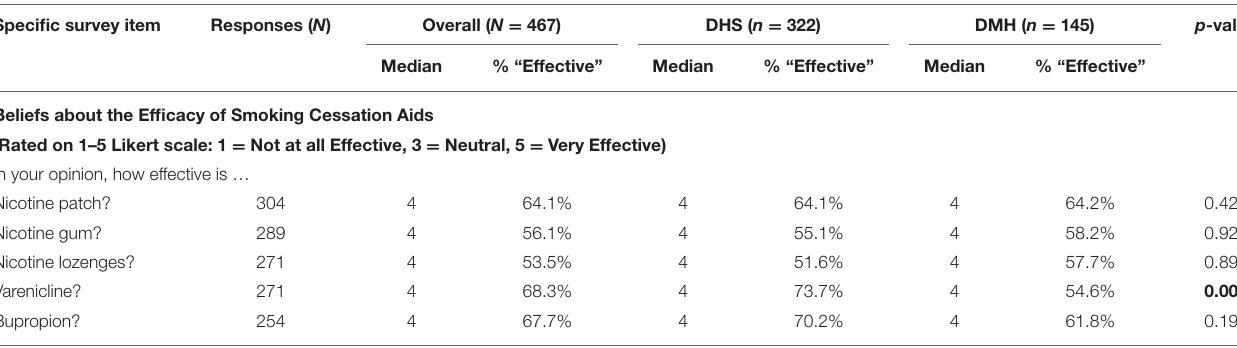
TABLE 2 | Comparing smoking cessation aid beliefs between DHS and DMH health agency providers. Specific survey